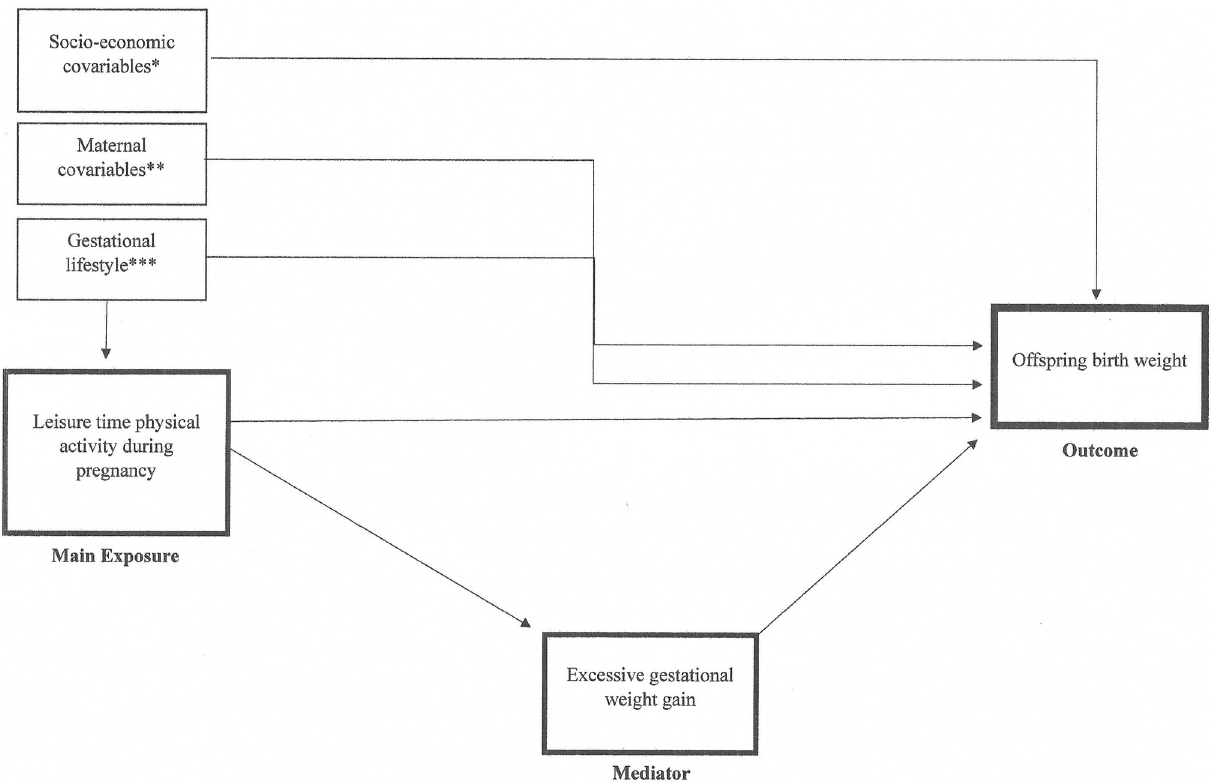
Fig 2. Proposed causal diagram among leisure time physical activity (LTPA) during pregnancy, gestational weight gain (GWG) and offspring birth weight. � Socioeconomic status baseline confounders included number of rooms in the household, household wealth index, living with a partner. �� Maternal covariables: pre-pregnancy BMI, age, primigravida. ��� Gestational lifestyle: frequency of fruit and vegetable consumption and ultra-processed food consumption, smoking during pregnancy.